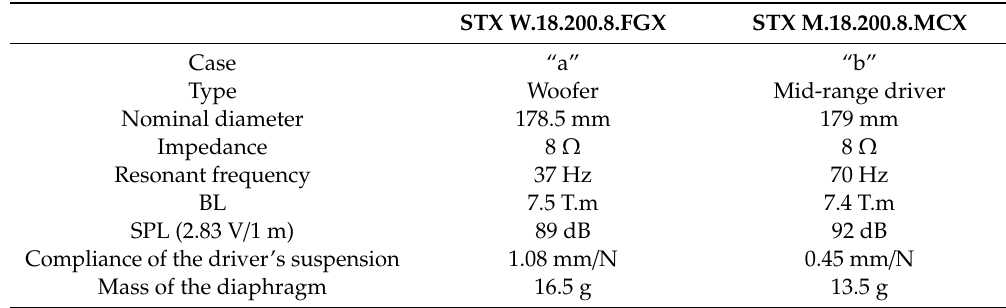
Table 1. Specification of the